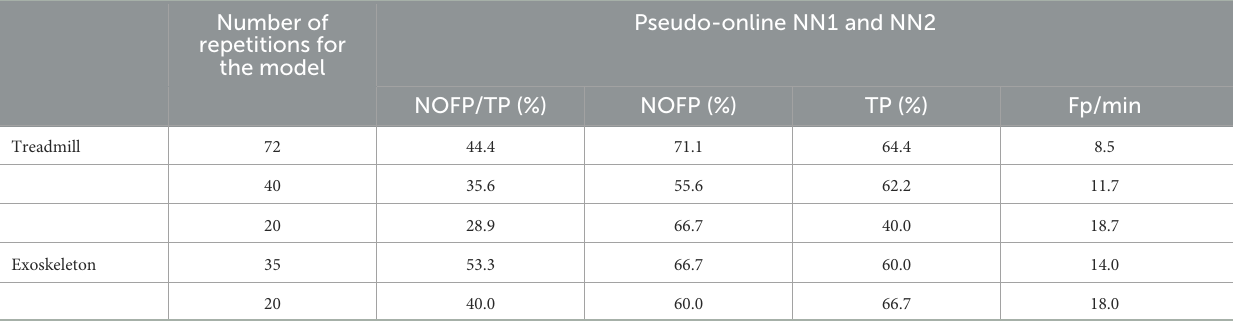
TABLE 8 Comparison of the BMI performance depending on the number of training repetitions used for the model creation for the treadmill and exoskeleton experiments with able bodied subjects.